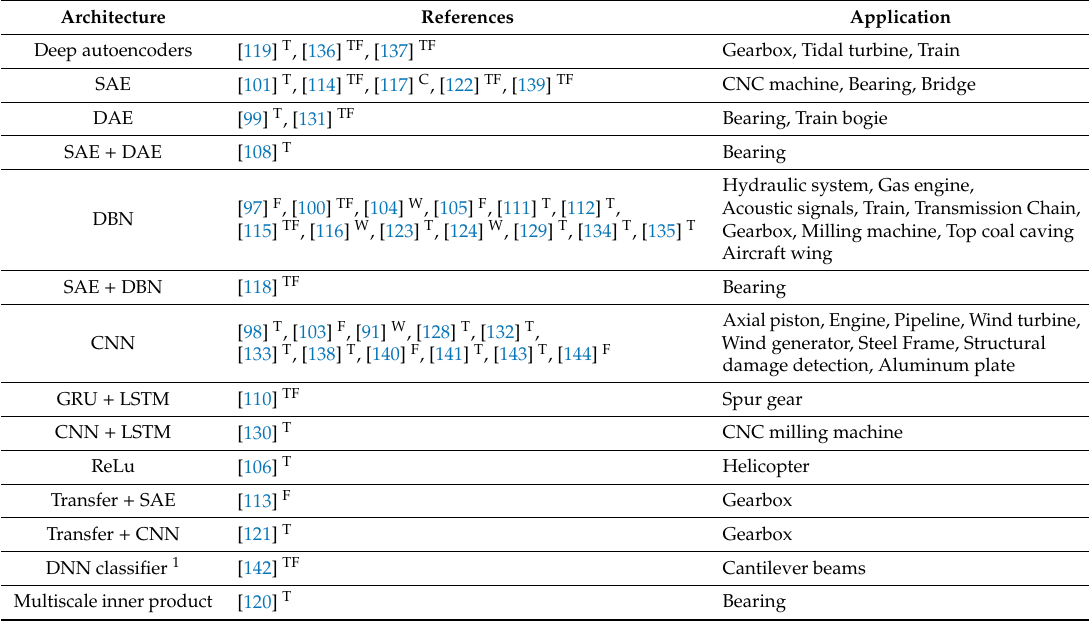
Table 2. Summary of deep-learning-based structural health monitoring by